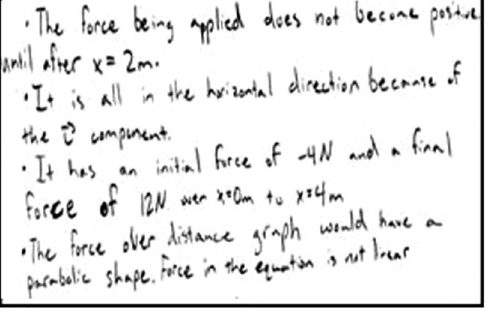
FIG. 19. Interpretation of force-position equation (question 6).